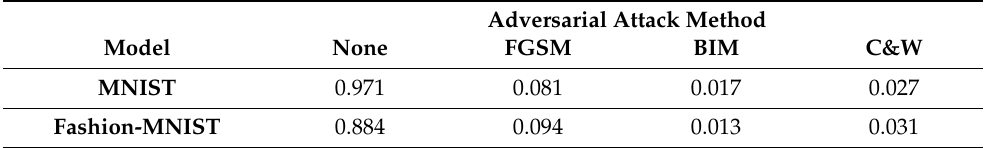
Table 4. Adversarial attack results on baseline target